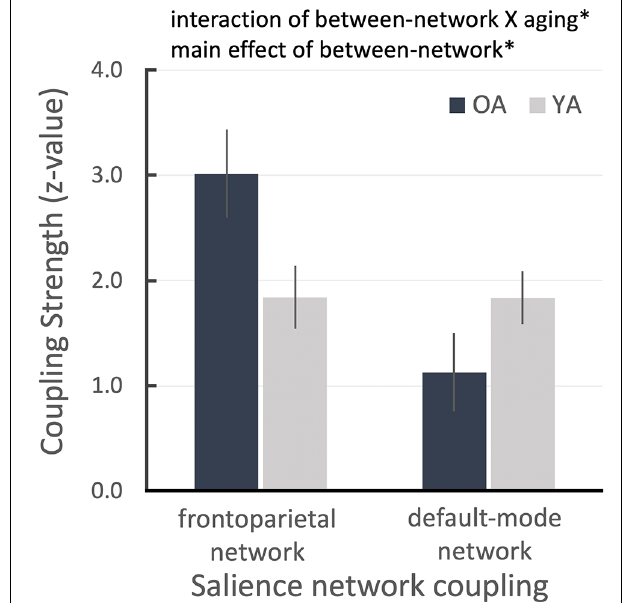
FIGURE 2 | ROI results for salience network seed-based functional connectivity analysis showing the salience network couplings with frontoparietal and default networks as a function of aging group. Error bars denote the standard error term. ∗ P <